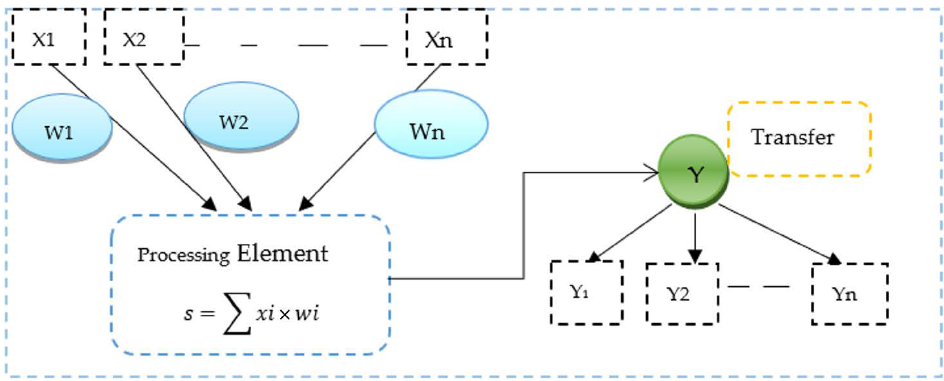
Figure 5. The basic concept of a neural-inspired model.